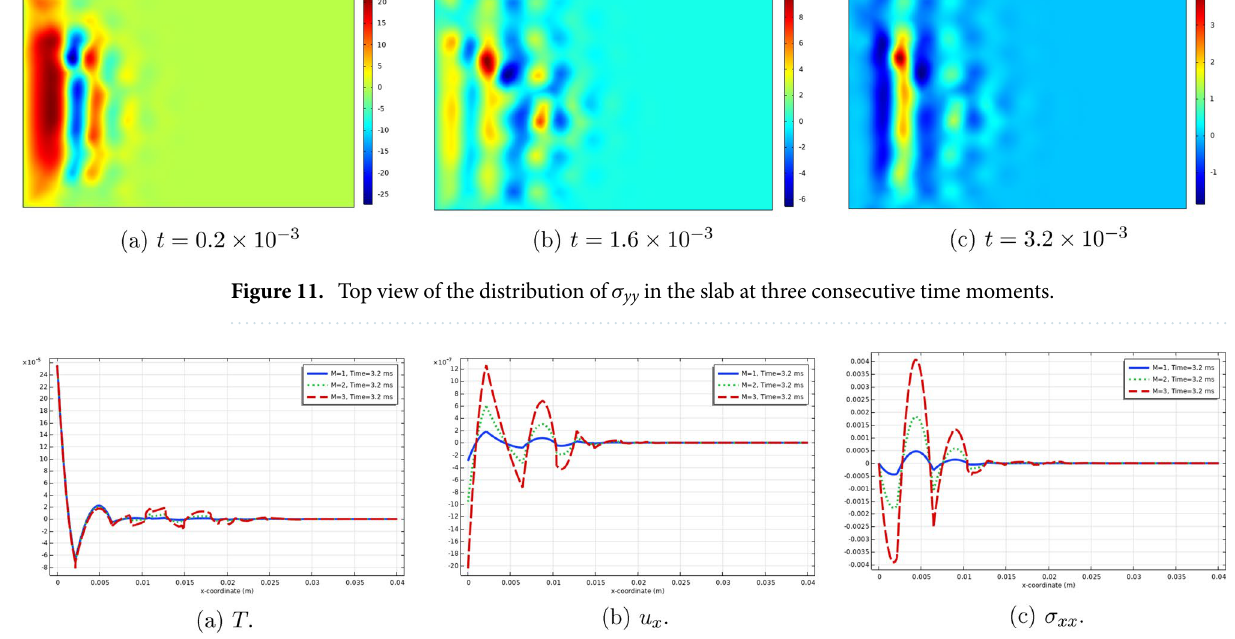
3 and three values of M 3.2 10 b / 2 for t − = = ×